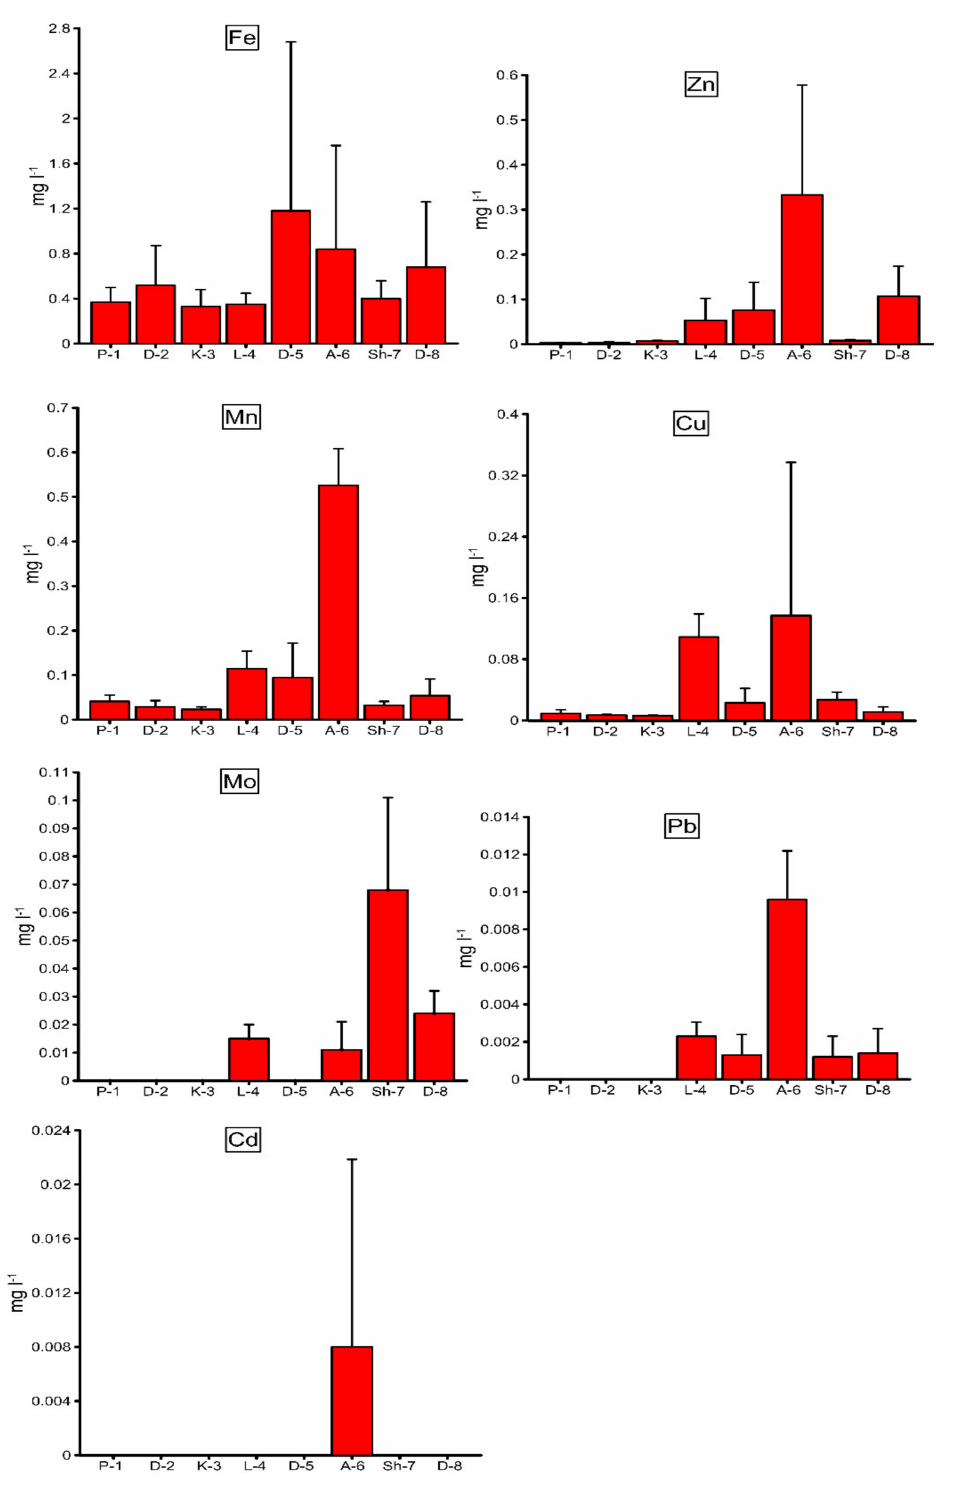
Figure 2. Spatial distribution of the average concentrations of some HMs in the river waters of the Debed catchment